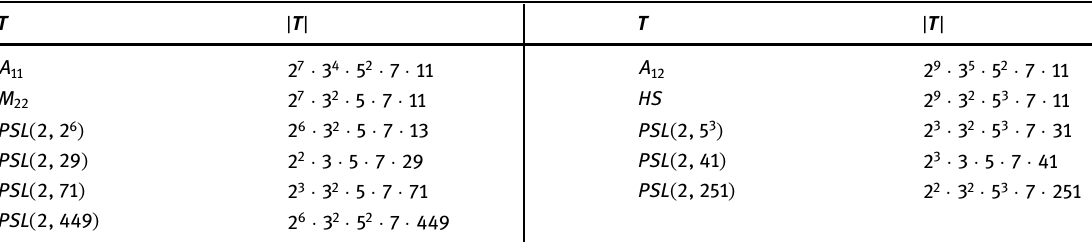
Table 5: The simple K 5 - groups in Lemma